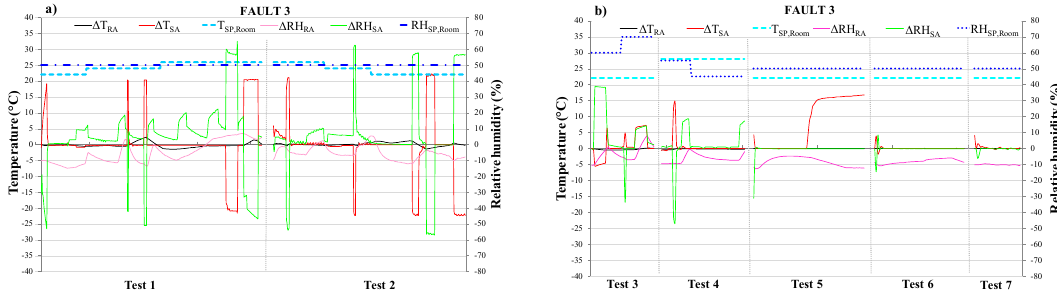
Figure 9. Comparison between normal operation and operation with fault 3: test 1, 2 ( a ), test 3, 4, 5, 6, 7 ( b ).